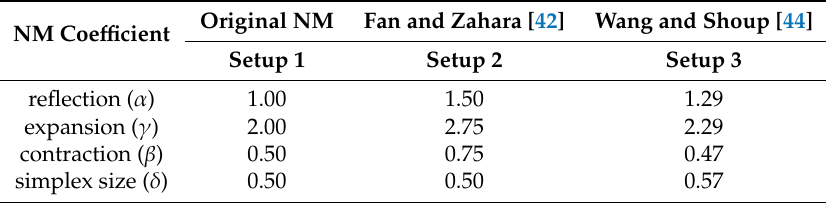
Table 1. A comparison of suggested Nelder-Mead (NM) coe ffi